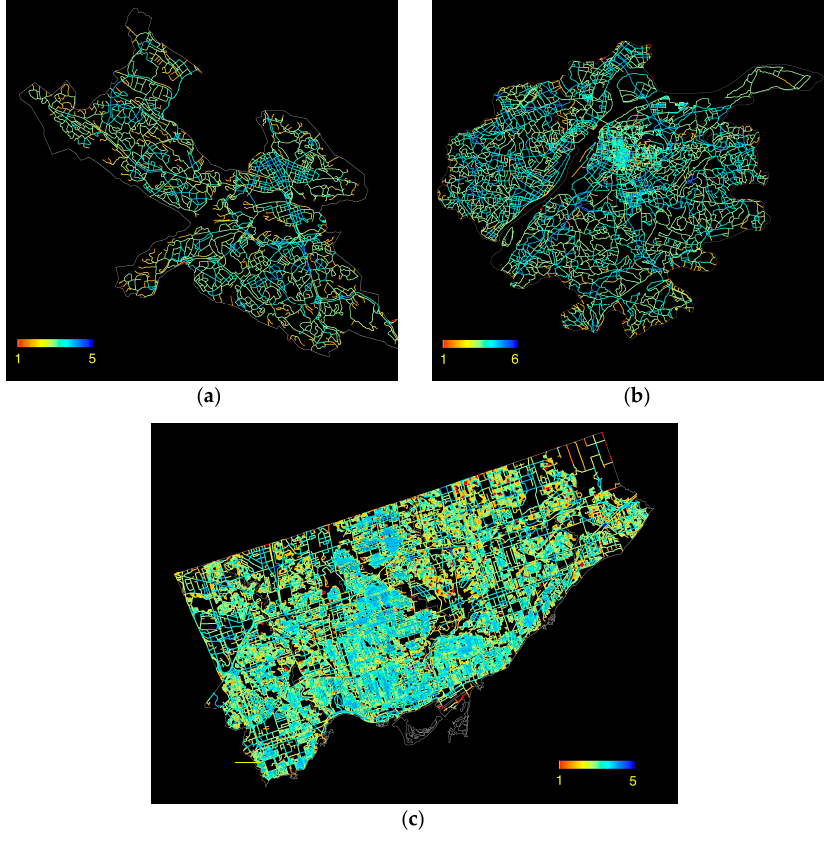
Figure 4. Degree distributions of the urban street systems of ( a ) Stockholm; ( b ) Nanjing, and ( c ) Toronto (the values of degree centrality are divided into 10 classes from the minimum to the maximum, corresponding to the color from red to blue).